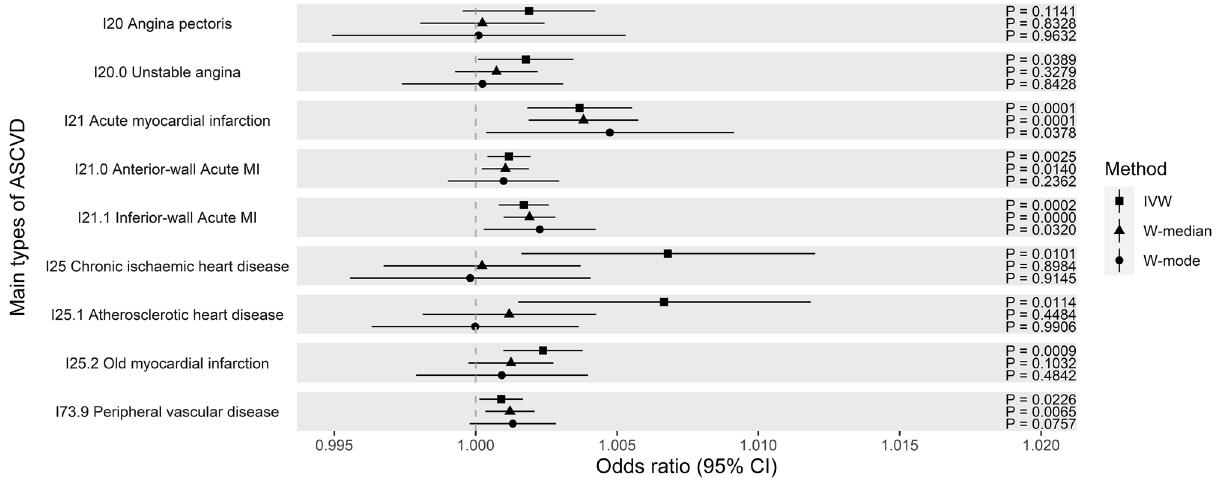
Figure 3. Causal estimates of CAC on subtypes of ASCVD outcomes (odds ratio with 95% confidence interval) using the UK Biobank